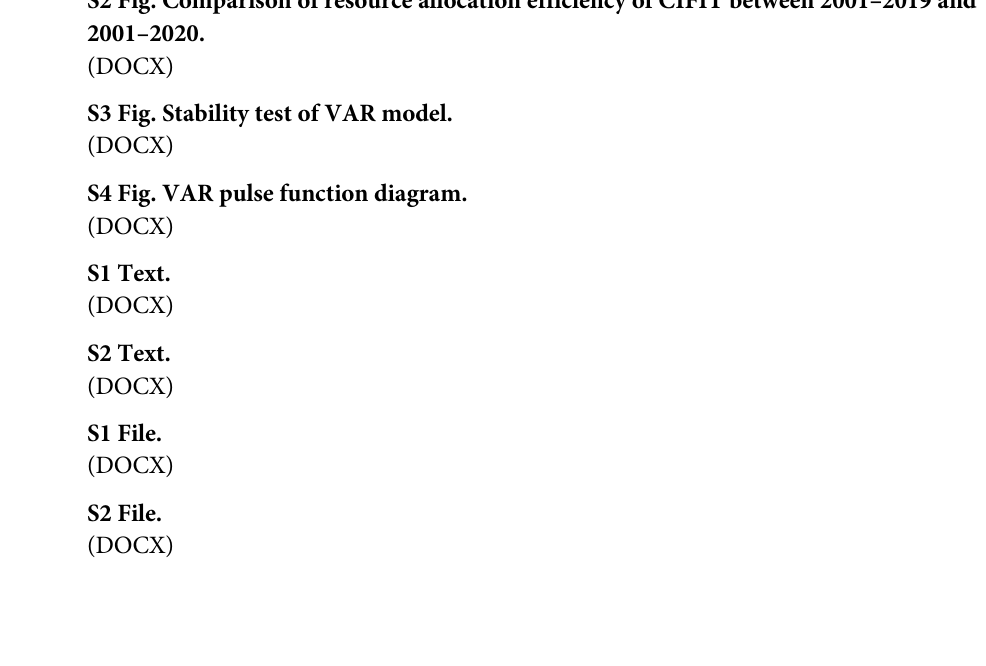
S1 Fig. Resource allocation efficiency of CIFIT 2001–2019 under BCC mode. S2 Fig. Comparison of resource allocation efficiency of CIFIT between 2001–2019 and